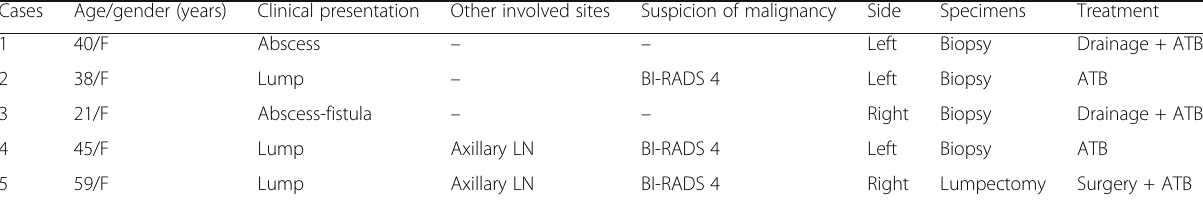
Table 1 Clinicopathological features of our patients diagnosed with breast tuberculosis Cases Age/gender